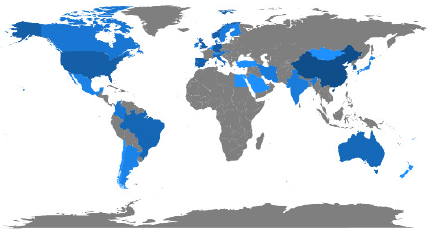
Figure 13. Country Scientific Production (ROA).